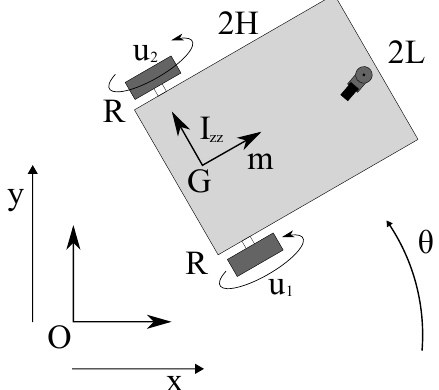
Figure 1. Unicycle-like mobile